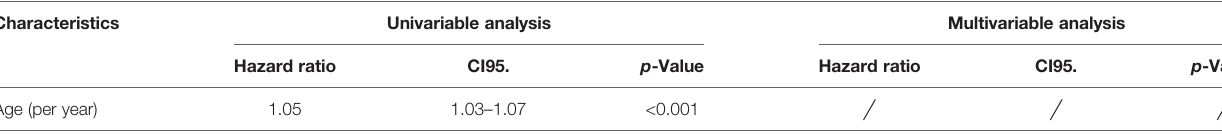
TABLE 6 | Univariate and multivariate analyses of OS in the venous invasion cohort. Characteristics